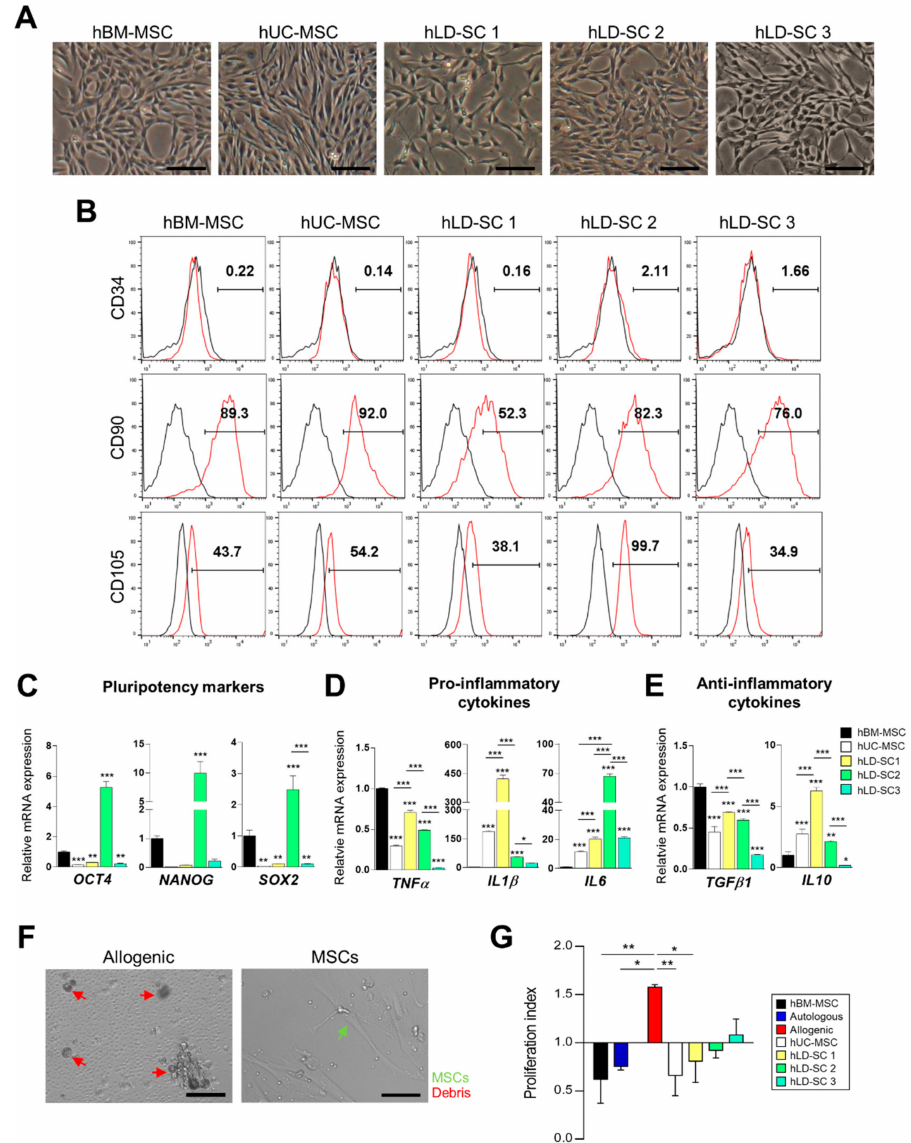
Figure 1. Comparison of the characteristics between human liver-derived stem cells (hLD-SCs) and mesenchymal stromal / stem cells (MSCs) from other origins. ( A ) Microscopy imaging of human umbilical cord matrix derived stem cell (hUC-MSCs), human bone marrow stem cell (hBM-MSCs), andhumanliver-derivedstemcells(hLD-SCs)isolatedfromthreedi ff erentindividuals. Scalebar, 200 µ m. ( B ) Flow cytometry measurement of hUC-MSCs, hBM-MSCs, and three hLD-SCs. CD34 was labeled as a hematopoietic stem cell marker. CD90 and CD105 were labeled as mesenchymal stem cell markers. ( C – E ) Quantitative real-time PCR (qRT-PCR) analysis of ( C ) pluripotency markers ( OCT4 , NANOG , and SOX2 ), ( D ) pro-inflammatory cytokines ( TNF α , IL1 β , and IL6 ), and ( E ) anti-inflammatory cytokines ( TGF β 1 and IL10 ). Gene expression levels were normalized to GAPDH expression and compared to the expression levels of hBM-MSCs. Data are expressed as mean ± SD. n = 4. ( F ) Microscopy measurement of the interaction process between allogeneic peripheral blood mononuclear cells (PBMCs) isolated from two di ff erent volunteers without or with mesenchymal stromal / stem cells (MSCs). Scale bar, 100 µ m. ( G ) Comparison of immune cell proliferation during MLR assay. Autologous, allogenic, and allogenic reactions after treatment with hBM-MSCs, hUC-MSCs or three hLD-SCs, respectively, were compared. The proliferation index was calculated by dividing absorbance of 96 h co-cultured cells at a wavelength of 450 nm to that of cells before treatment. P -values < 0.05 were considered significant. n = 4, *, p < 0.05; **, p < 0.01; ***, p <